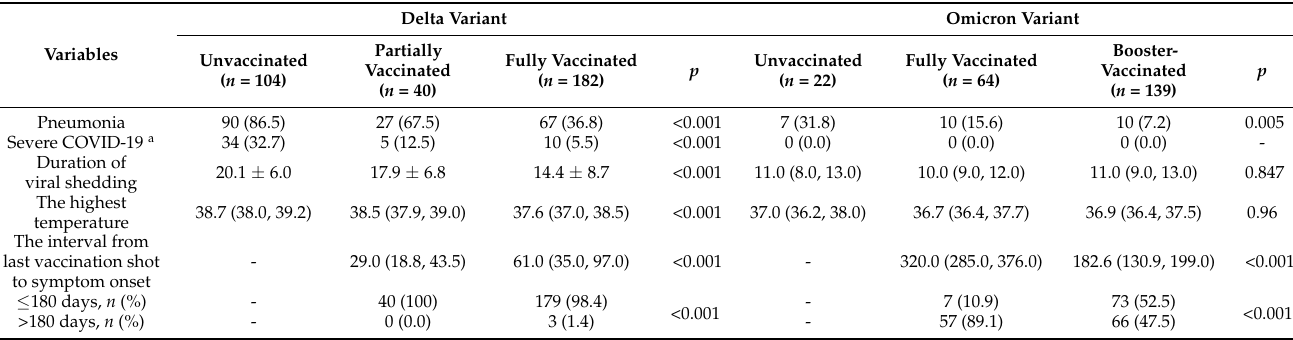
Table 3. Outcomes and interval from last shot to symptom onset in Delta and Omicron infections stratified by vaccination